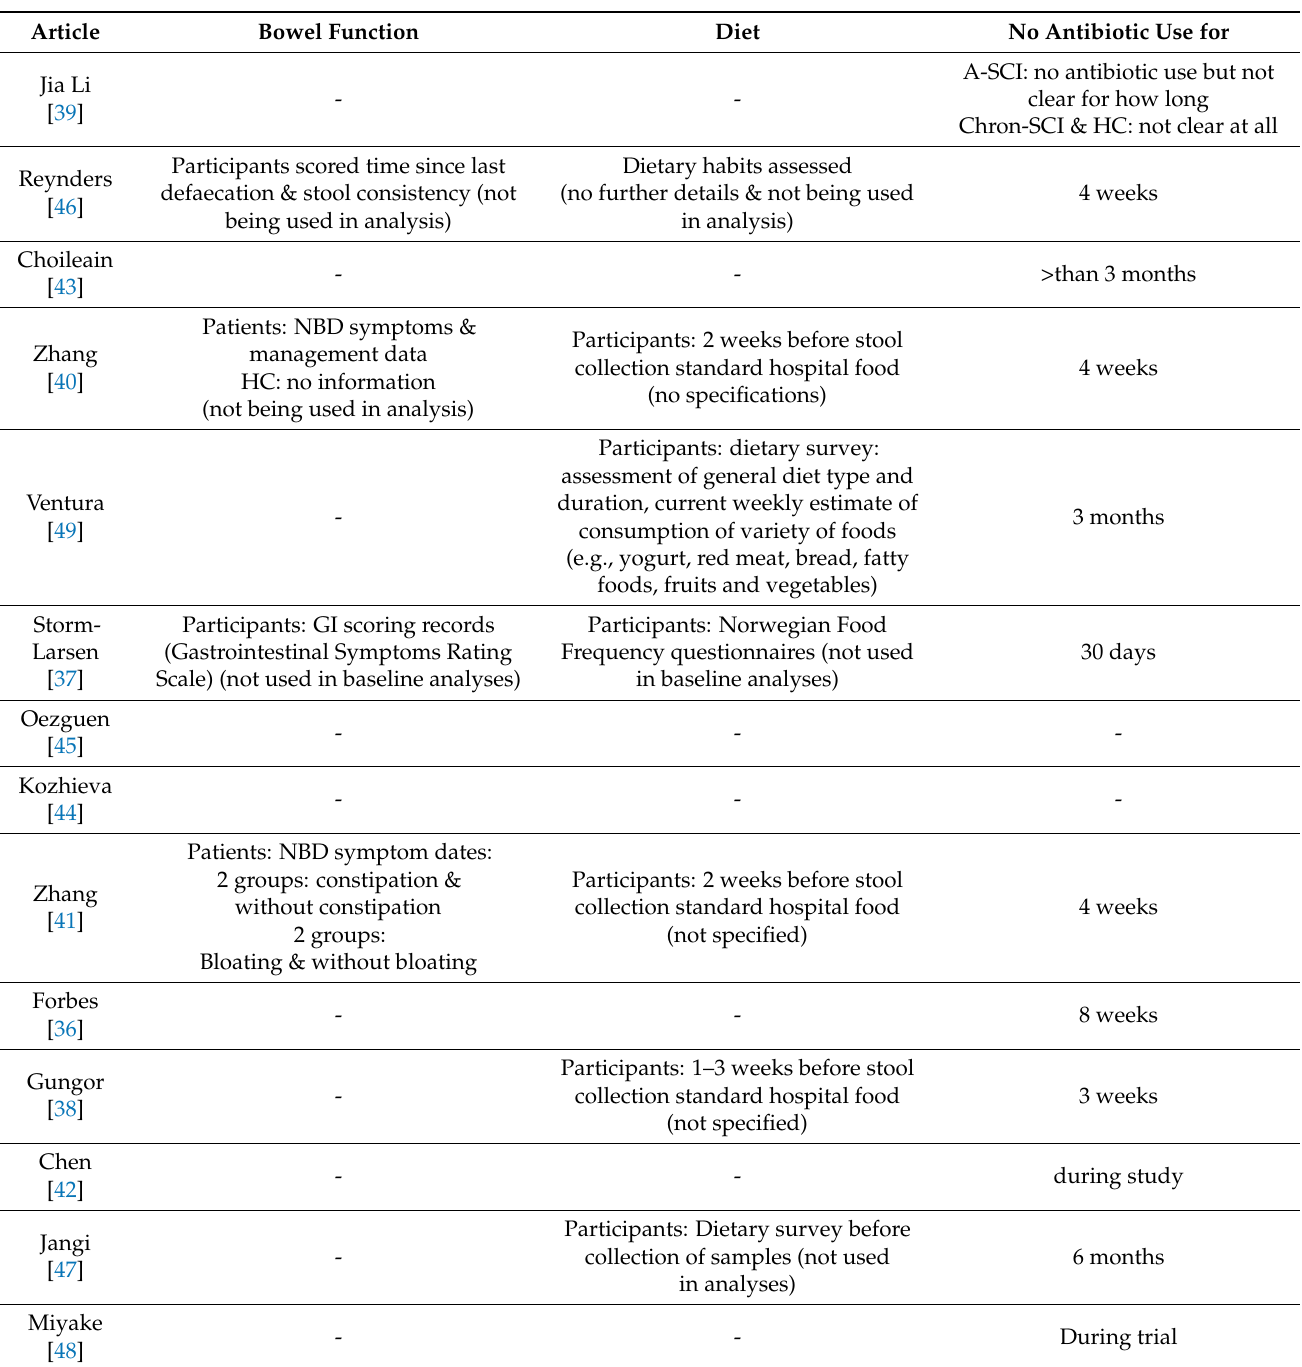
Table 3. Overview of how the individual studies addressed or assessed bowel function, diet and antibiotic use. An empty cell means the studies did not provide this